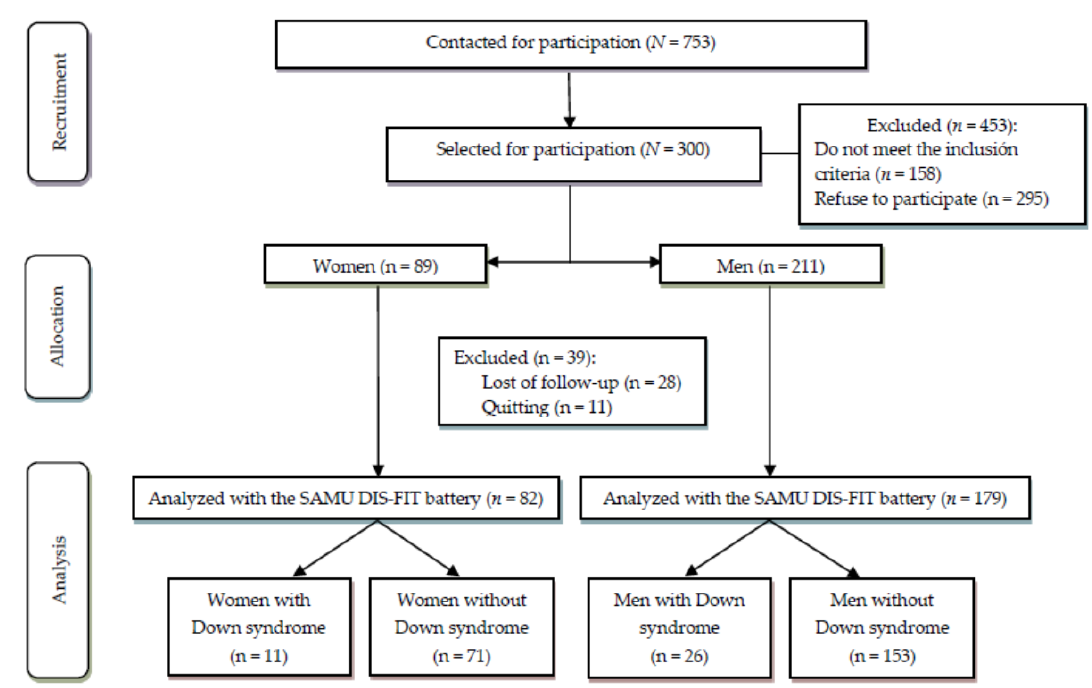
Figure 1. Study flowchart.